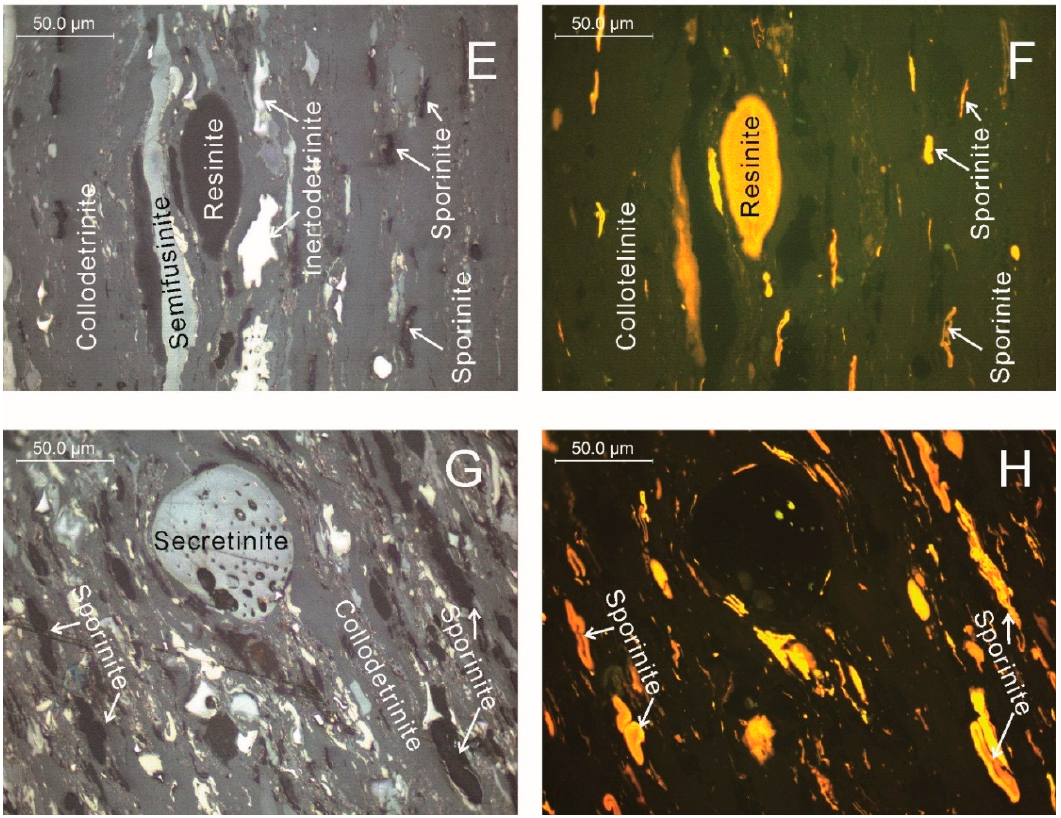
Figure 5. Macerals in the Upper No.3 coals. ( A ) Sporinite, corpogelinite, inertodetrinite, and colledetrinite (LBS3U-4); ( B ) Sporinite under fluorescent light (LBS3U-4); ( C ) Cutinite, sporinite, and colledetrinite (LBS3U-13); ( D ) Cutinite and sporinte under fluorescent light (LBS3U-13); ( E ) Resinite, inertodetrinite, sporinite, semifusinite and colledetrinte (LBS3U-6); ( F ) Resinite and sporinite under fluorescent light (LBS3U-6); ( G ) Secretinite, sporinite, collodetrinite (LBS3U-4); ( H ) Sporinite under fluorescent light (LBS3U-4). A , C , E , and G are under oil reflectance white light.